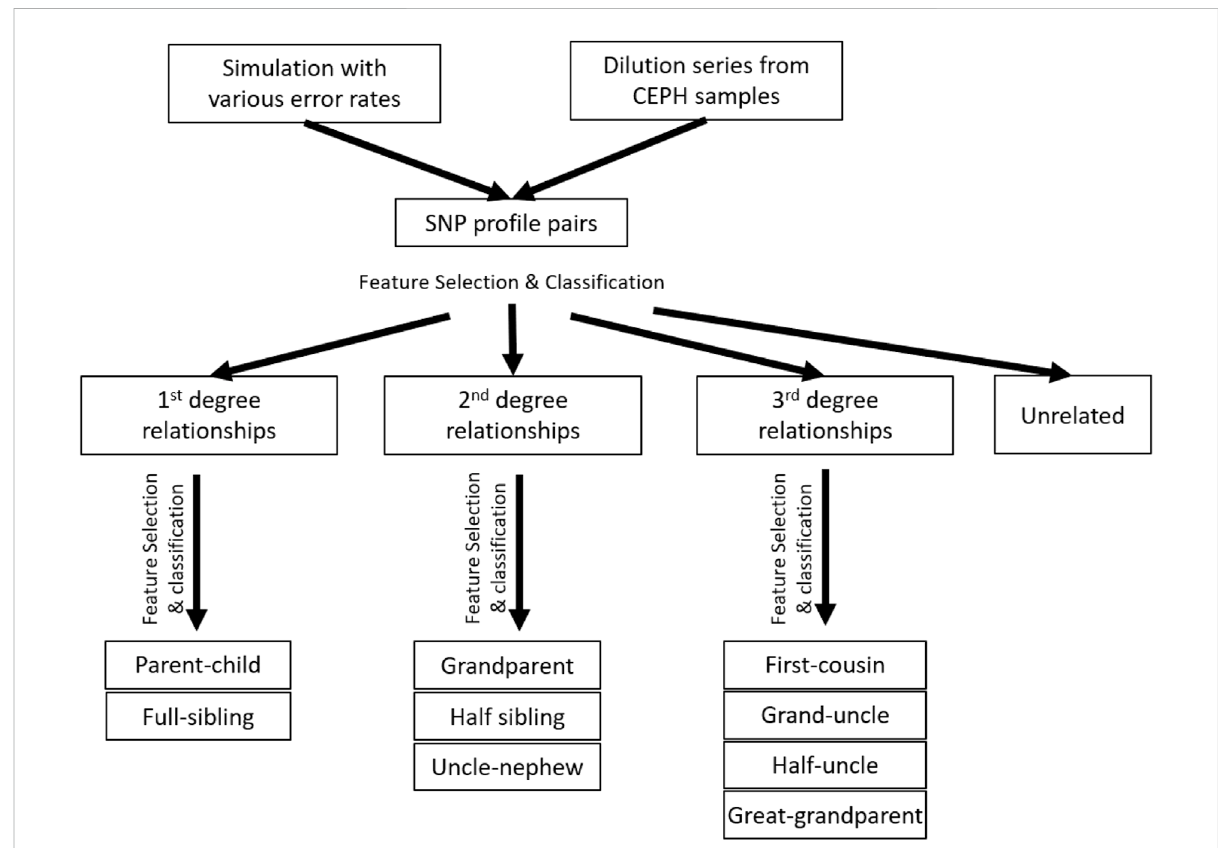
FIGURE 2 Experimentaldesignandwork fl owofthewholestudy.Thehierarchicalclassi fi cationwasimplementedwiththesimulationdata,butnotthereal data, as the sample size of the real data was too